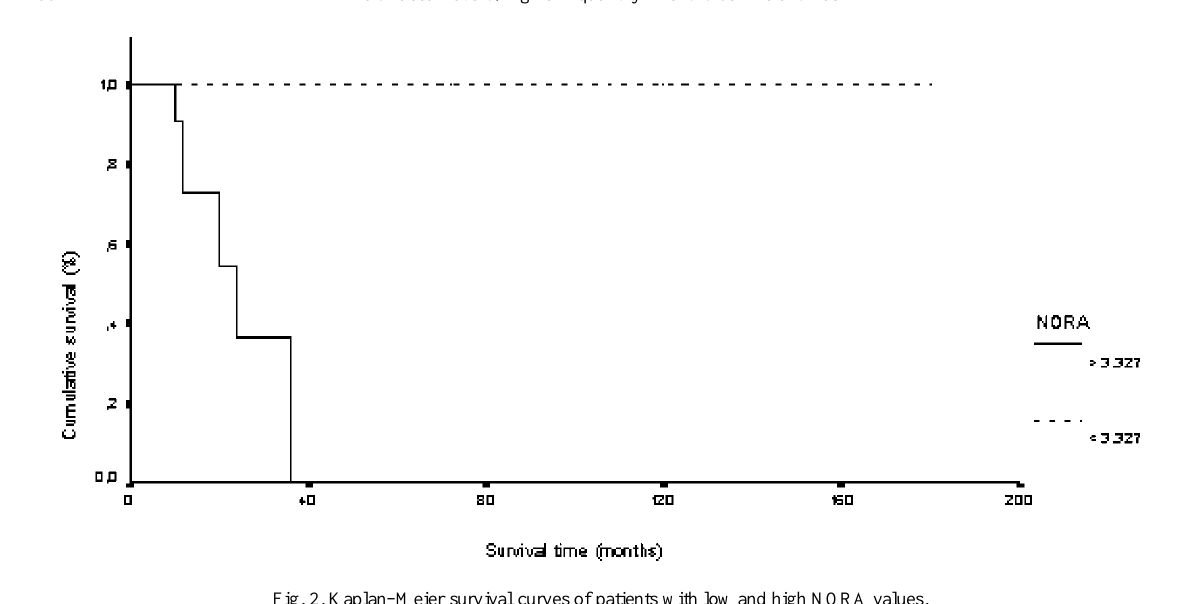
Fig. 2. Kaplan–Meier survival curves of patients with low and high NORA